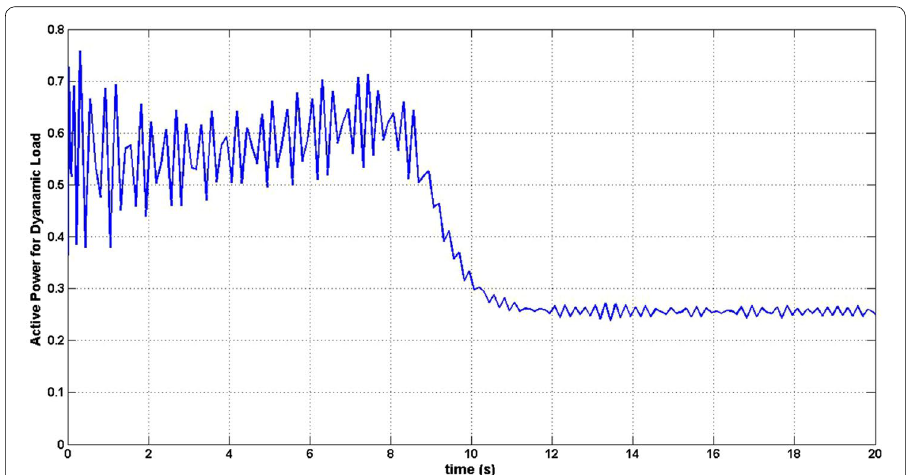
Fig. 8 The reactive power of DG source with increases in dynamic load of 1%